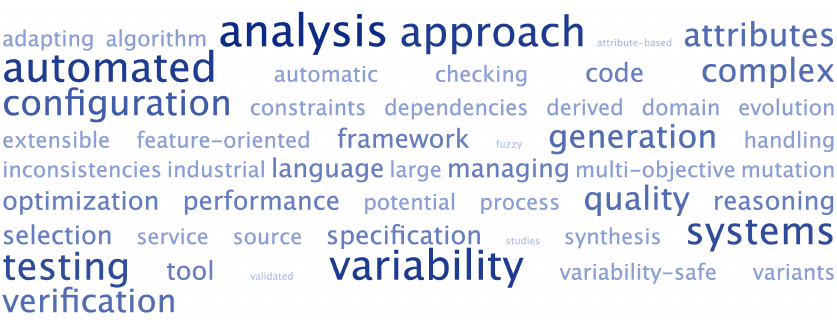
Figure 22. Weighted word cloud derived from titles of selected papers.